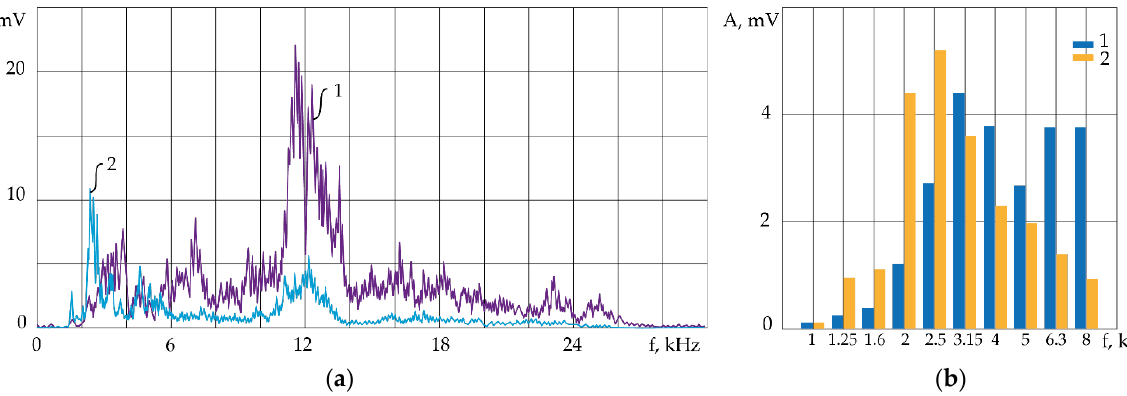
Figure 3. Working area of the Agie Charmilles CUT 1000 OilTech machine with installed accelerometers: 1 — electrode- workpiece; 2 — electrode- tool; 3 — accelerometer and acoustic emission sensors.